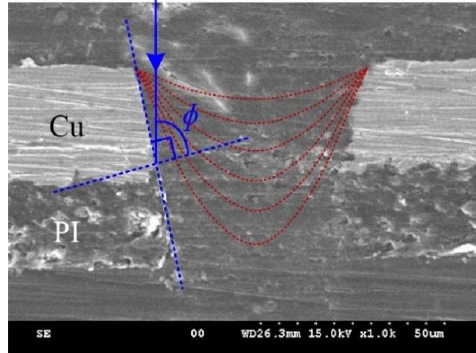
Figure 7. Schematic image of the incident angle between the direction of the incident beam and the surface normal.